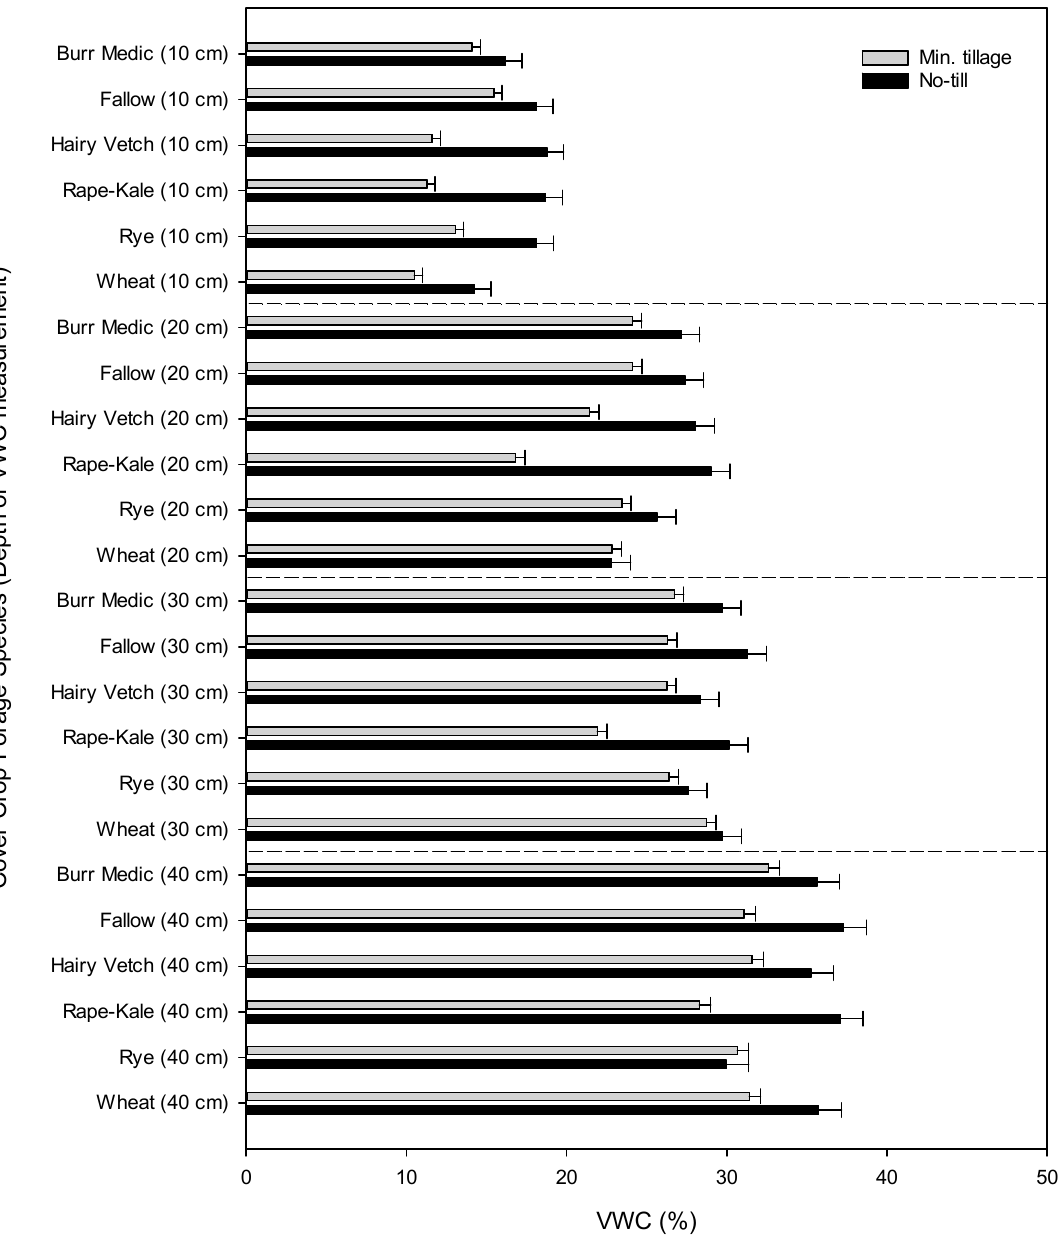
Figure 5. Comparison of average weekly volumetric water content at four depths: 10 cm, 20 cm, 30 cm, and 40 cm. Data were analyzed within depth and averaged over irrigation treatments. Fallow represents the unplanted control. Error bars represent standard